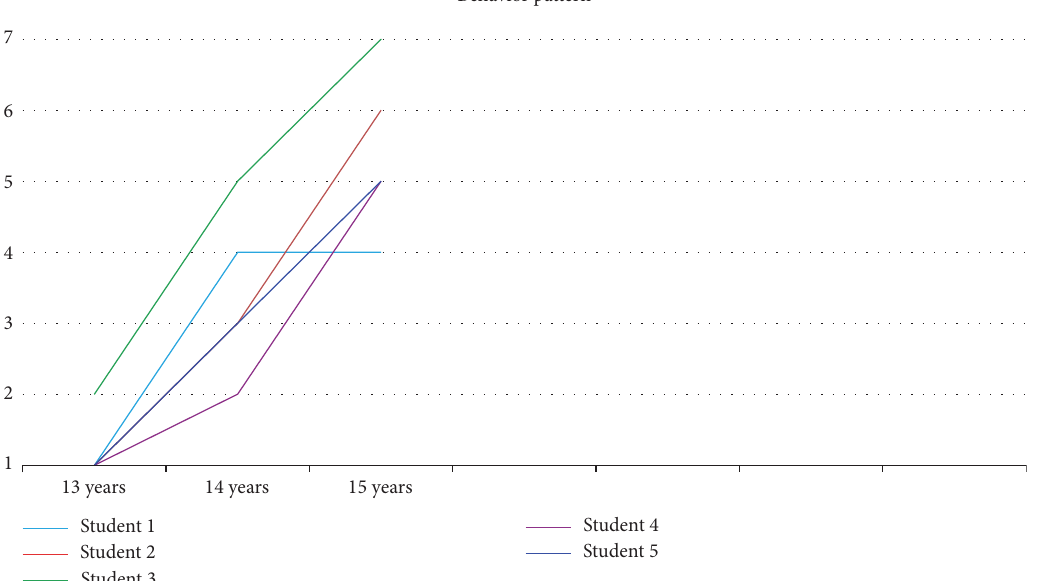
F IGURE 3: The graph of behavior